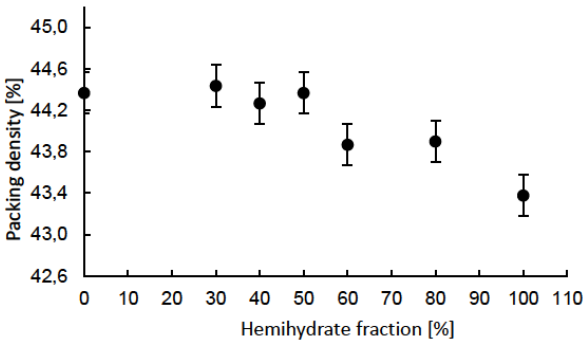
Figure 5: Effect of hemihydrate fraction within cement gypsum phase on cement paste